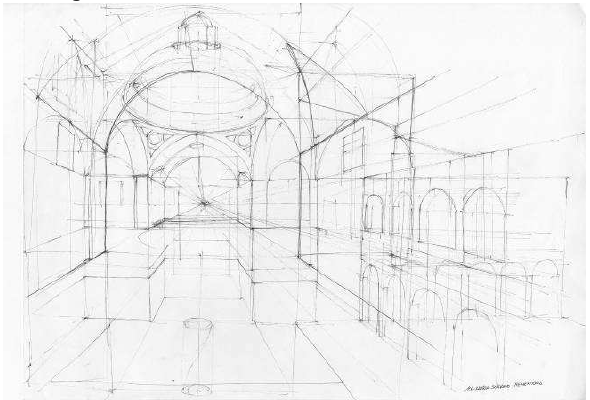
Figure 17. Spatial interpretation Teachers also teach the students the possibility of changing uses within the old buildings and the students propose actions and proposals on this heritage.